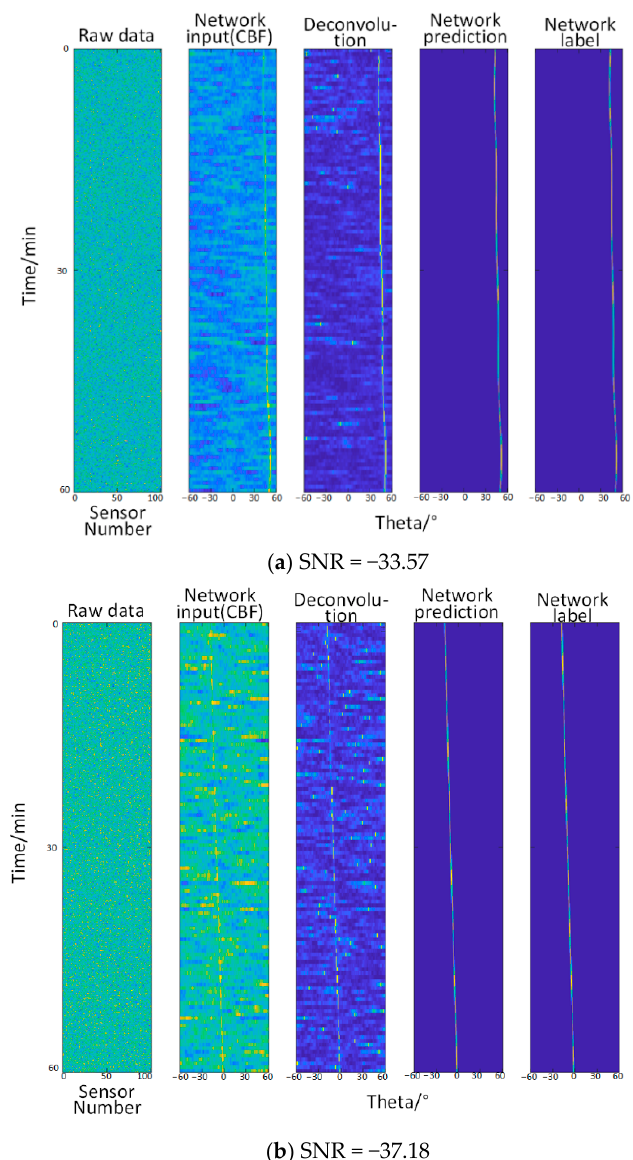
Figure 4. ( a , b ) are respectively the angle recognition results and prediction results of different methods under different signal-to-noise ratio conditions. ( a , b ) from left to right: original data (the abscissa is the sensor number, and the ordinate is the time), the input of the network (the abscissa is the angle, and the ordinate is the time, which is the same below), deconvolution method, the prediction of the network, and the network label (true trajectory).